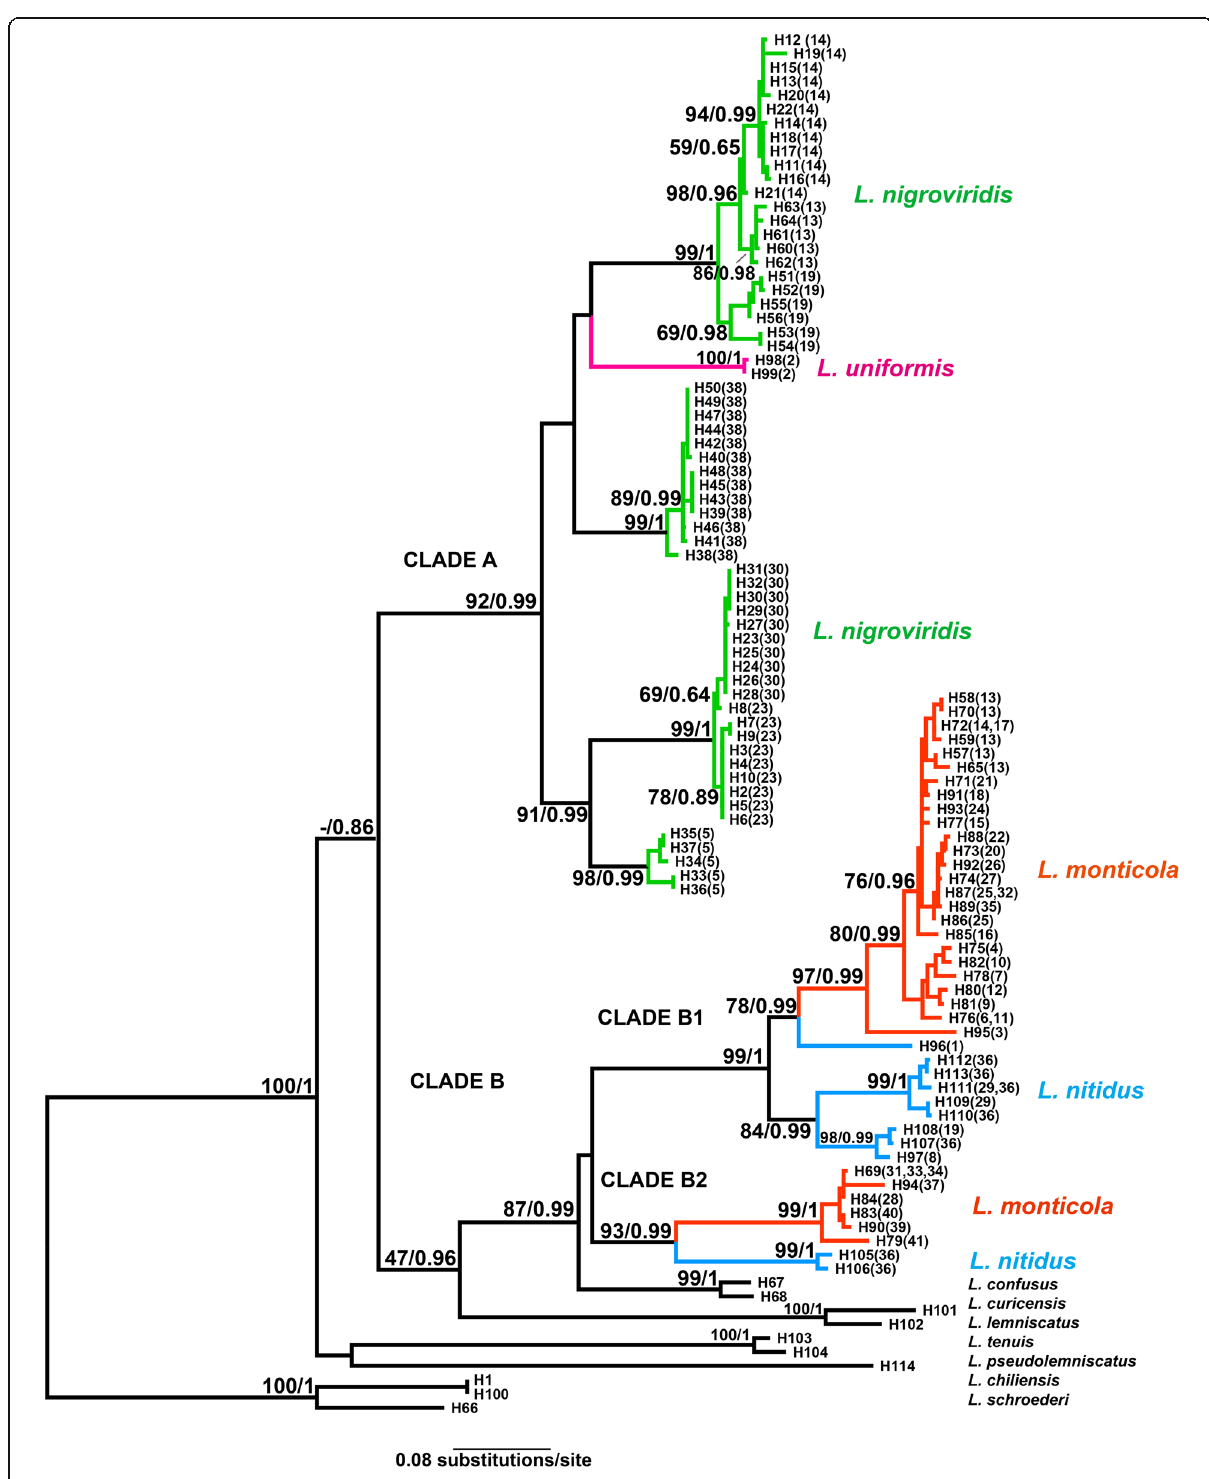
Fig. 2 Maximum likelihood tree of eleven species of the genus Liolaemus. Maximum likelihood tree of eleven species of the genus Liolaemus based on the mitochondrial gene cytochrome b . Numbers on the branches indicate bootstrap values for maximum likelihood and posterior probabilities for Bayesian inference. Branches of the focal species are shown in colors: L. nigroviridis ( green ) and L. monticola ( orange ): L. uniformis is shown in pink and L. nitidus in light blue . Information on haplotypes is given in Additional file 1: Table